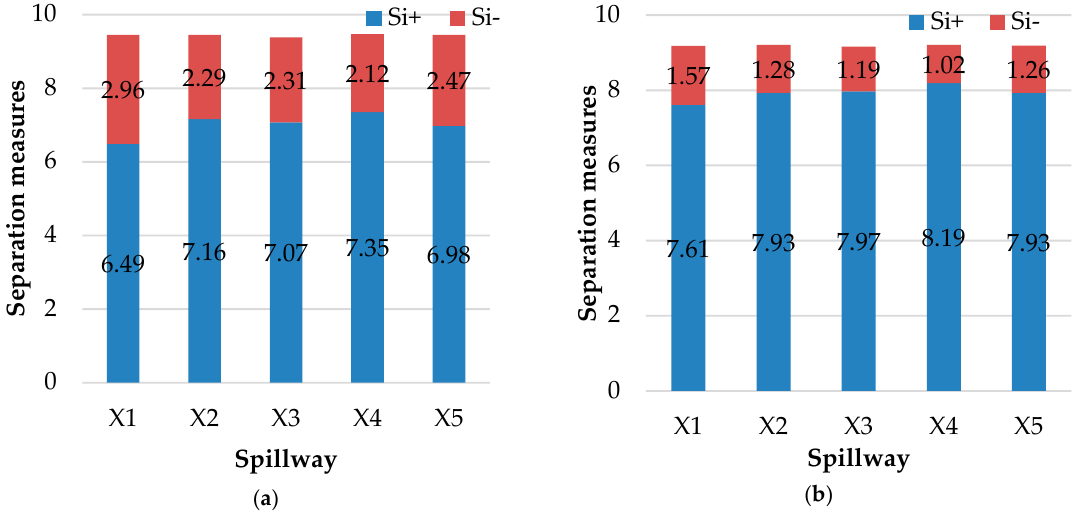
Figure 3. Separation measures; Ideal separation (S i+ ). Negative-ideal separation (S i − ). ( a ) 1st approach (linear scale transformation); ( b ) 2nd approach (Jahanshahloo et al.